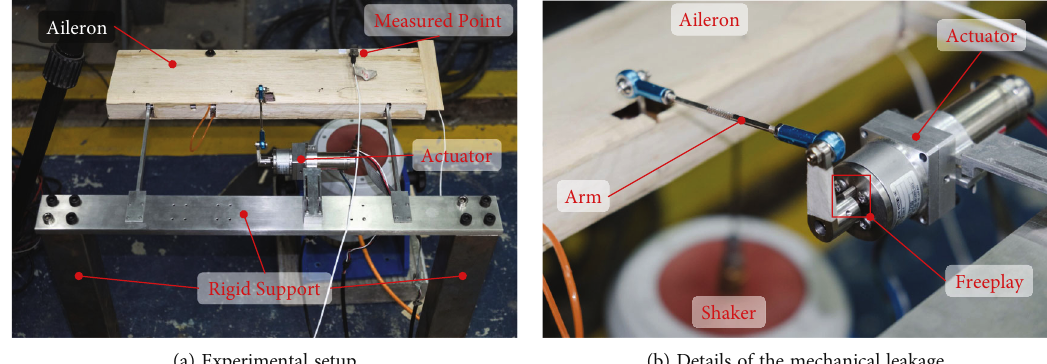
Figure 11: Experimental setup of nonlinear system identi fi cation of freeplay.